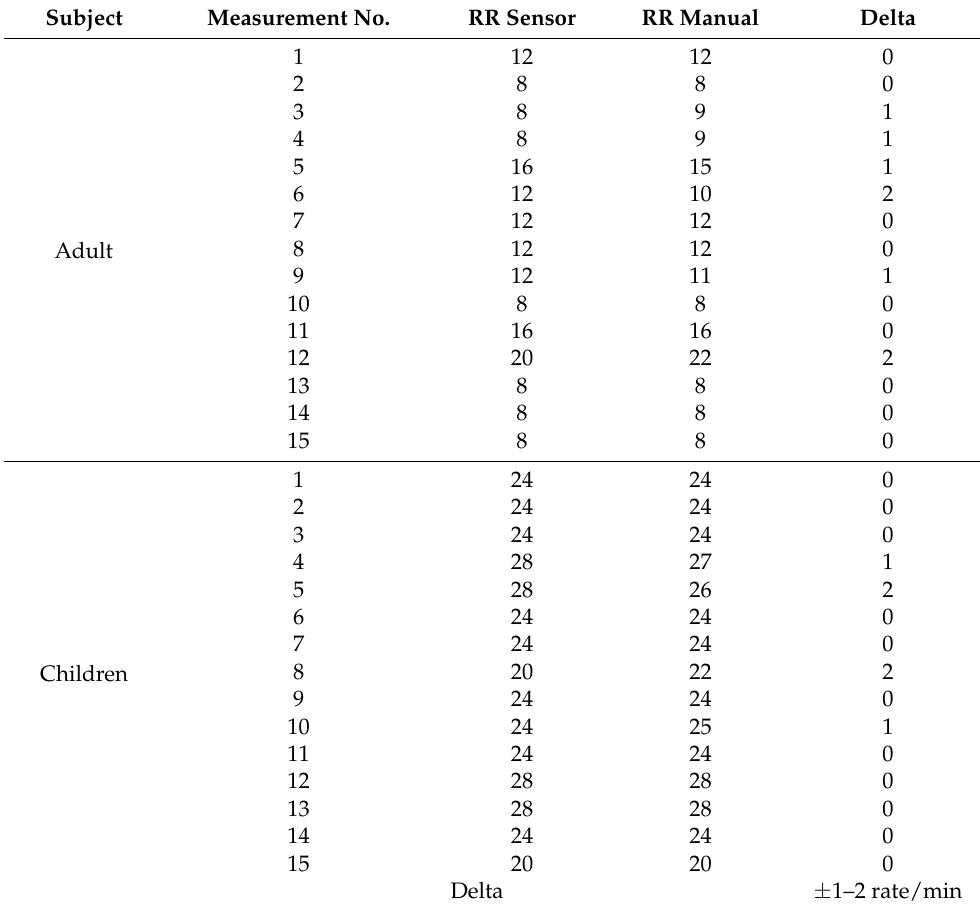
Table 4. Comparative results of respiration rate calculation on normal breathing.